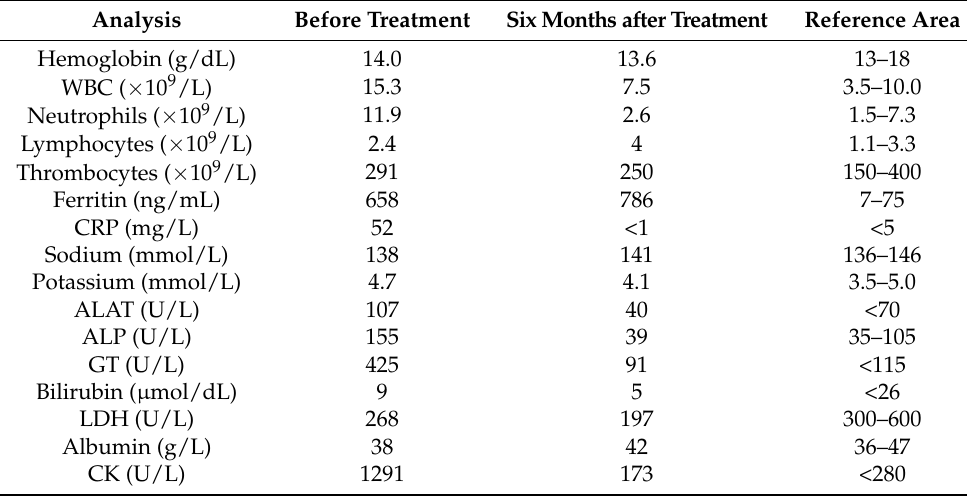
Table 1. Diagnostic blood tests from the patient, both before and after